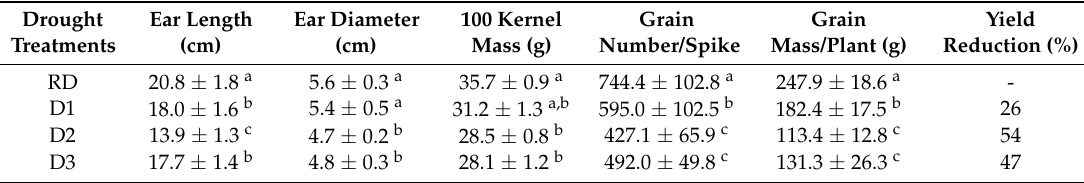
Table 1. Yield component of maize under different drought stress.